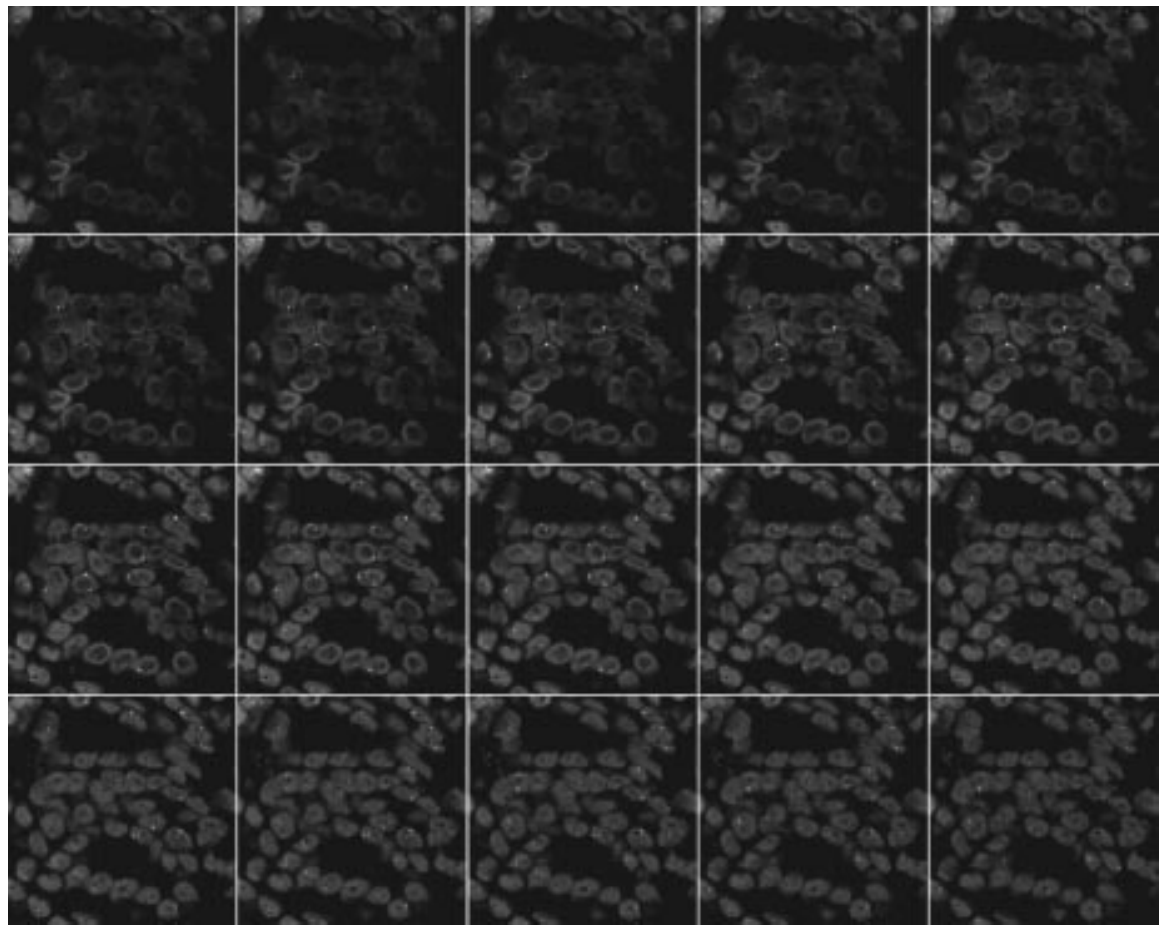
Fig. 4. Evaluation of gene copy number changes for Her-2/ neu -specific probes (red signals) and chromosome 17 centromeric probes (green signals) counterstained with TO-PRO TM -3 iodide in case #4 using laser scanning microscopy. A sequence of images from an selected areas was scanned in steps of 0.5 (cid:22) m for signal